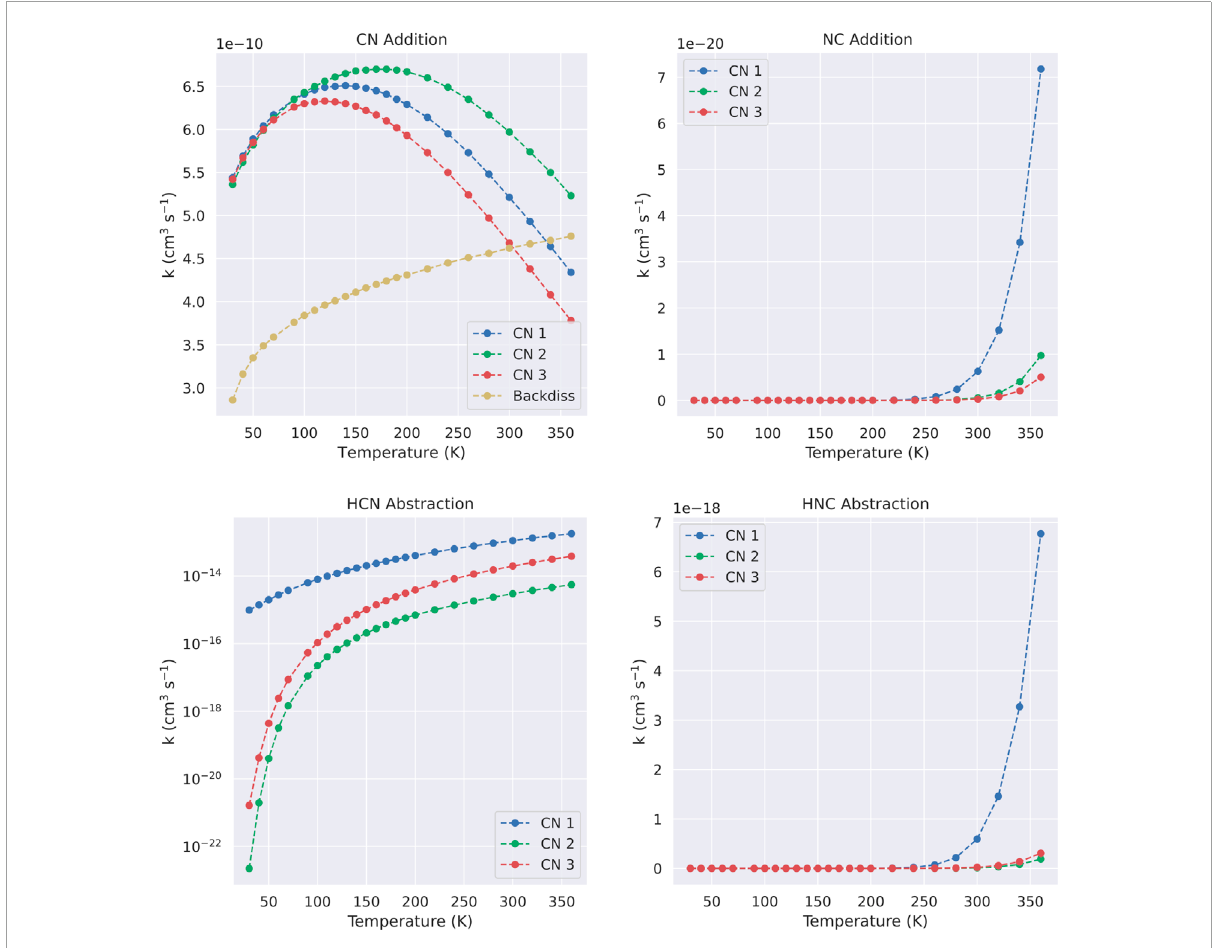
FIGURE 6 Global rate constants for the different reactions considered in this work. Note that for C 5 H 5 N + CN → C 5 H 4 N + HCN we employ a semilogarithmic